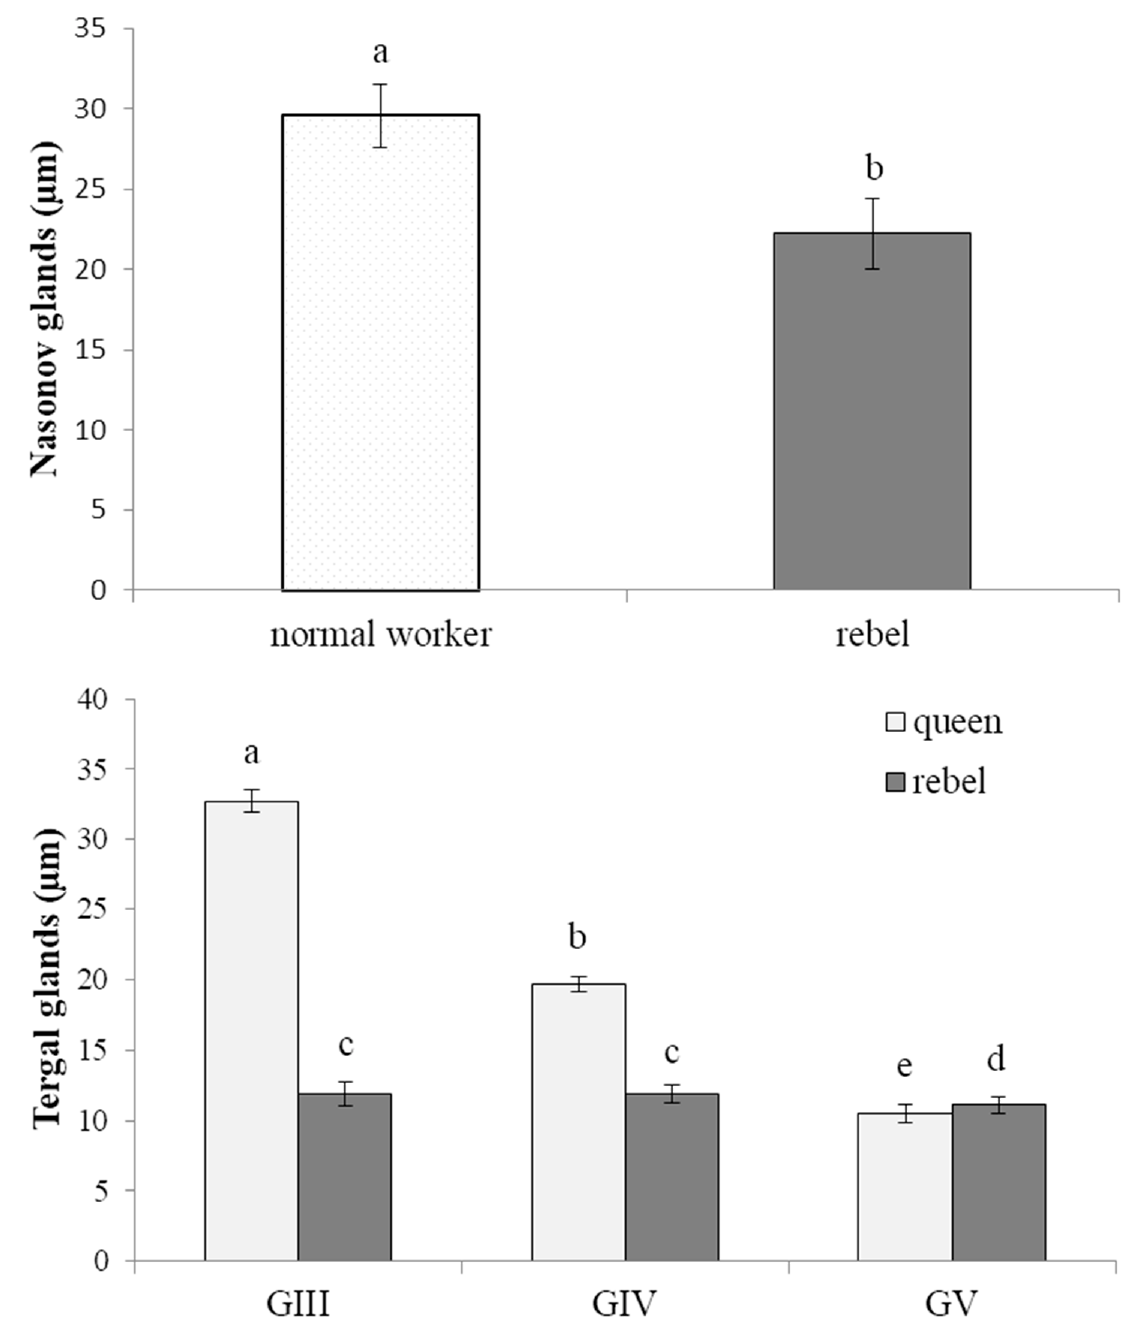
Figure 4. Diameters of the cell nuclei in the Nasonov and tergal glands. The small letters indicate significant differences ( p ≤ 0.05) between the rebels and normal workers in their Nasonov glands (two-way ANOVA with Tukey multiple comparison colony: F 2,114 = 0.51, p = 0.664; phenotype: F 1,2 = 248.1, p = 0.004; colony * phenotype F 2,114 = 8.09, p < 0.001) and between the rebels and queens in their tergal glands (three-way ANOVA with Tukey multiple comparison: colony: F 2,342 = 5.2, p = 0.006; location of tergal gland: F 2,4 = 9157.7, p < 0.001; phenotype: F 1,2 = 18,074.3, p < 0.001; colony * location of tergal gland: F 4,342 = 0.1, p = 0.995; colony * phenotype: F 2,342 = 0.7, p = 0.517; phenotype * location of tergal gland: F 2,342 = 8053.3, p < 0.001; phenotype * location of tergal gland * colony: F 2,342 = 3.7, p = 0.005). GIII—tergal glands from the third tergites; GIV—tergal glands from the fourth tergites; GV—tergal glands from the fifth tergites.